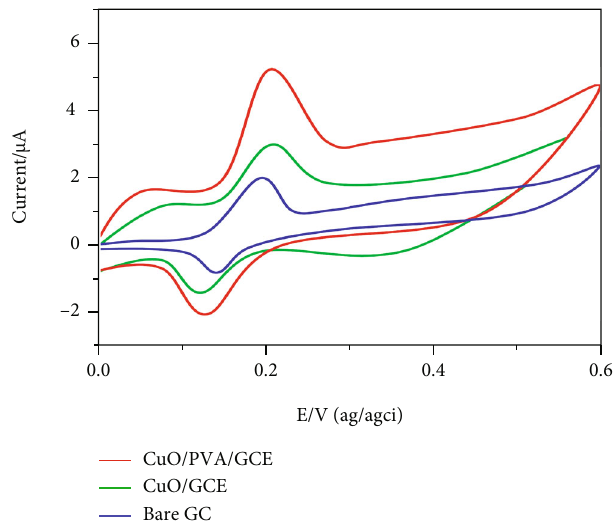
Figure 6: CV curve of CuO/GCE and CuO/PVA/GCE in a 0.1M PB solution at the scan rate of 50 mVs − 1 .